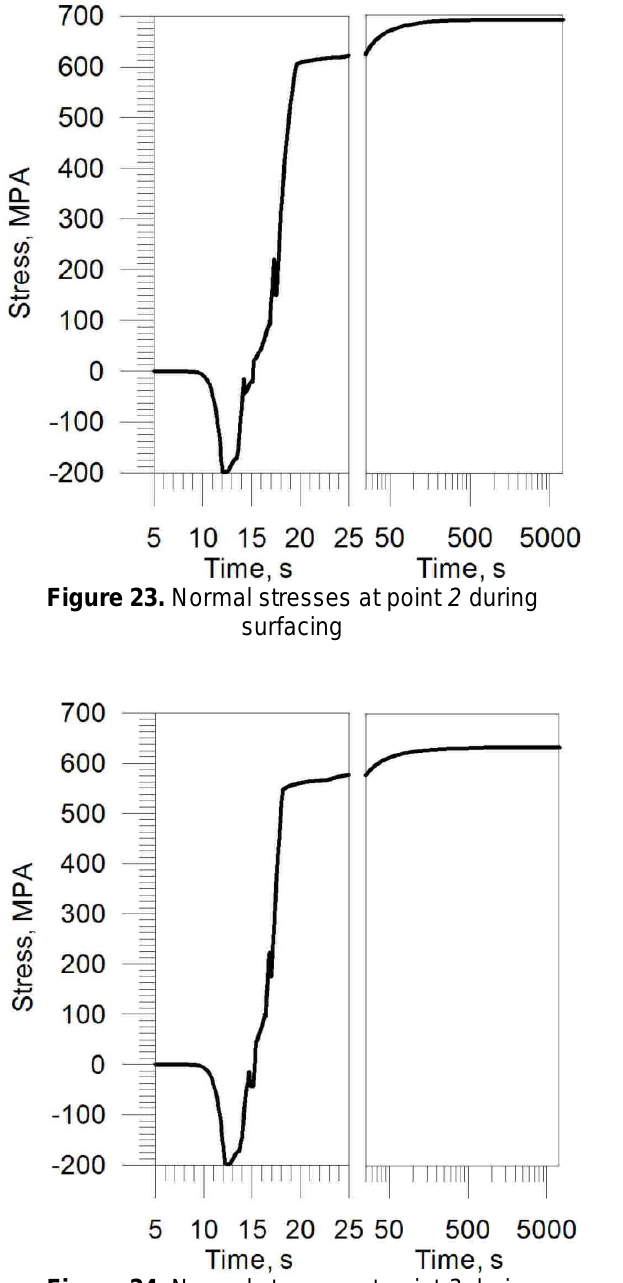
Figure 24. Normal stresses at point 3 during surfacing